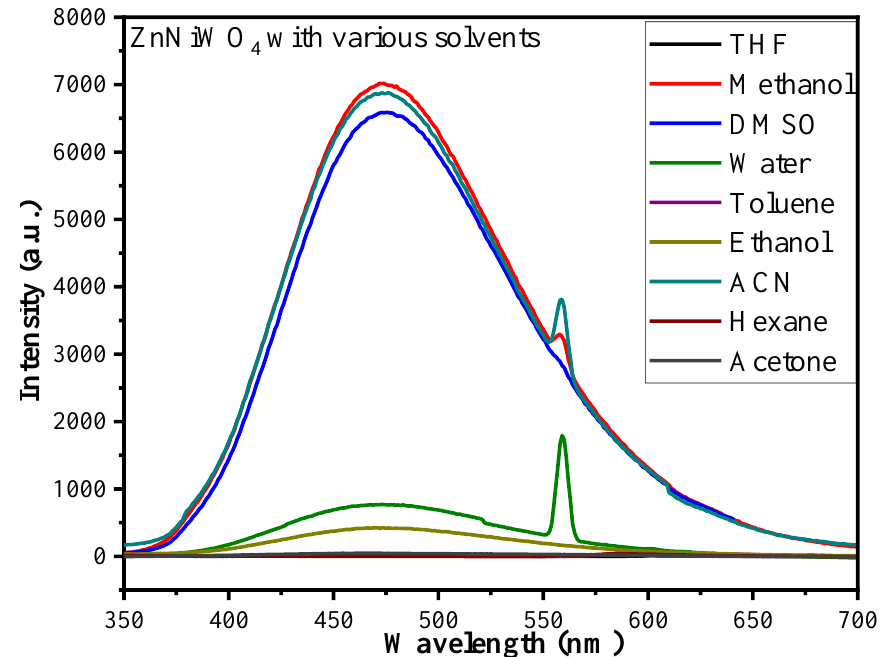
Figure 8. Solvent selection at which ZnNiWO 4 exhibited maximum fluorescence intensity obtained at 320 nm excitation wavelength.